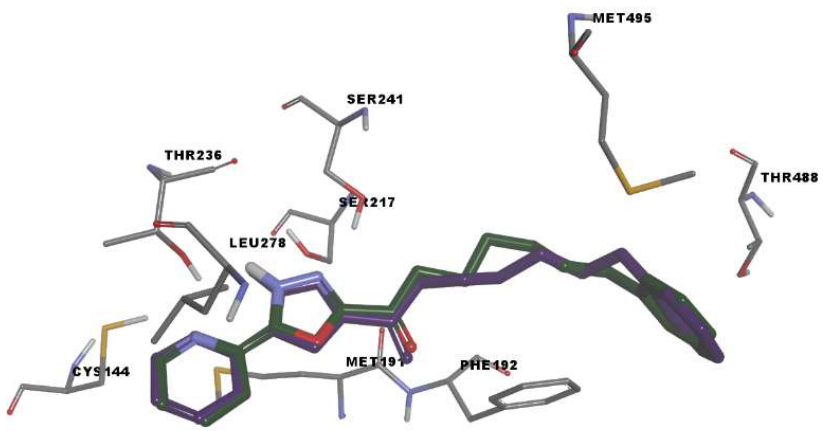
Figure 3. Rigid receptor docking (RRD) of the co-crystalized ligand at the active site of FAAH. It shows a cognate re-docked pose (purple) of JG1 compared with a co-crystallized pose (green). The simulated protein-JG1 complex revealed that in non-covalent binding mode, the inhibitor interacts with key residues Ser217 and Ser241 and participate in halogen interactions with residues delimiting the oxyanion hole (Ile238–Ser241) while the terminal phenyl group in the acyl side chain of the inhibitor establishes weak interactions in the cytosolic